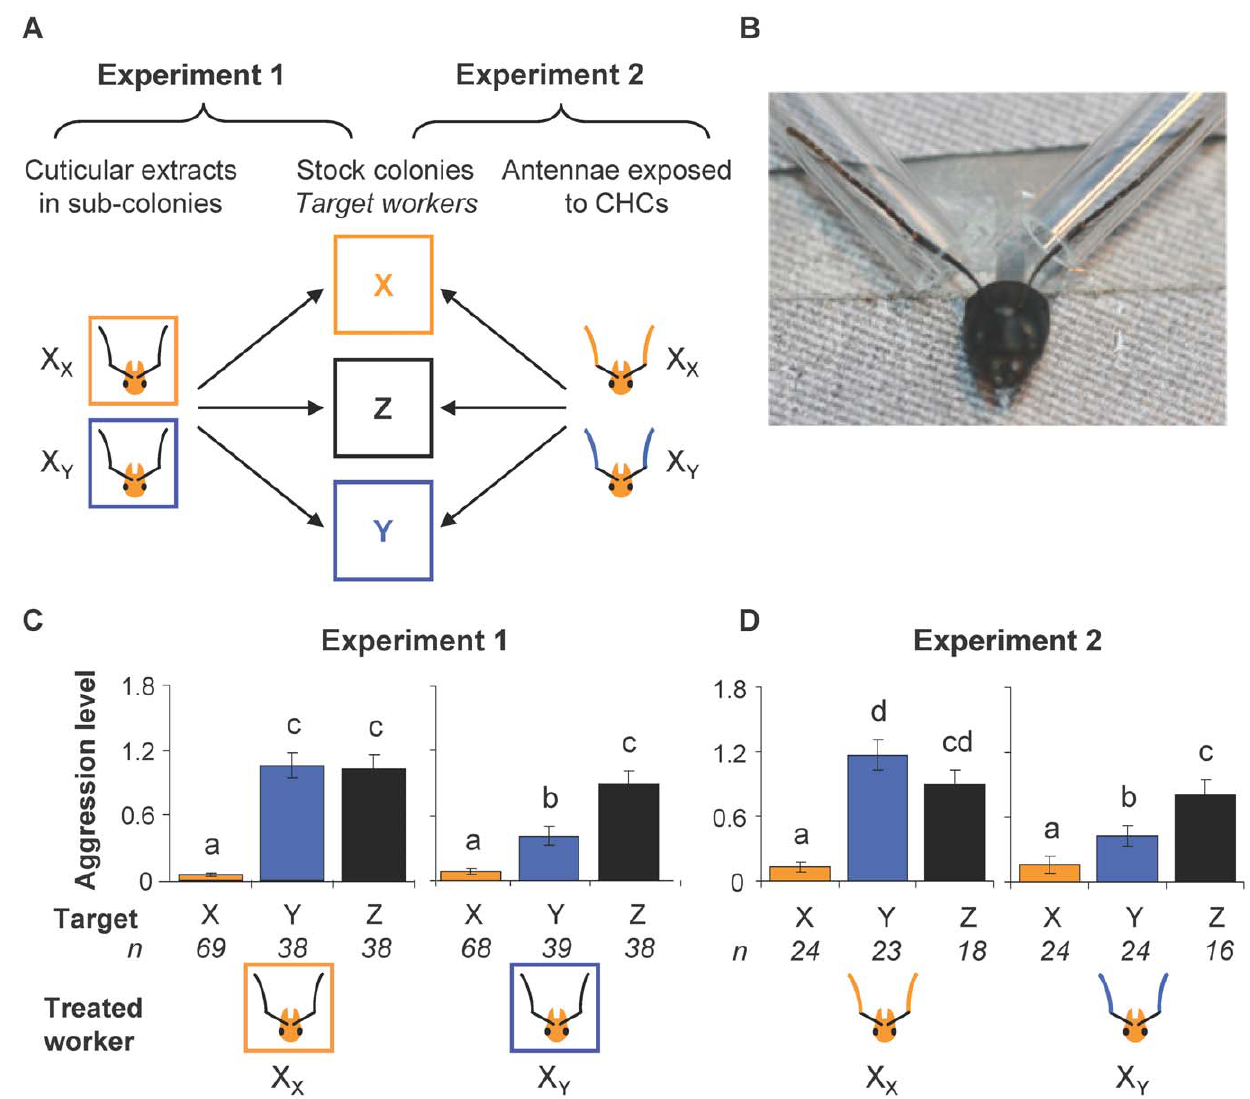
Figure 1. Effect of exposure to alien colony odor on nestmate recognition. ( A ) Experimental design. Workers from colony X were exposed to the odor of either nestmates (X X ) or non-nestmates from colony Y (X Y ), either inside sub-colonies during 24 hours (experiment 1) or directly on their antennae during 18 hours (experiment 2). Aggression tests between treated workers and anaesthetized target workers from colonies X, Y or unrelated alien Z were performed immediately after exposure as indicated by the arrows. ( B ) Restrained worker in the antennal exposure device. The picture shows CHC-coated glass capillaries positioned around the worker’s antennae. ( C, D ) Aggression level of treated workers towards targets from colonies X (yellow bars), Y (blue bars) and Z (black bars) in experiments 1 (C) and 2 (D). Columns and error bars indicate mean and standard error of aggression indices respectively. Different letters indicate significant differences between categories (mixed-effects model with least square means post-hoc comparisons, P , 0.05). X Y workers were significantly less aggressive towards non-nestmates from colony Y than X X workers (X Y –Y vs. X X –Y: P , 0.0001 in both experiments). However, treatments did not influence aggressiveness towards nestmates (X X –X vs. X Y –X, experiment 1: P =0.808; experiment 2: P =0.837) or non-nestmates from colony Z (X X –Z vs. X Y –Z, experiment 1: P =0. 322; experiment 2: P =0.